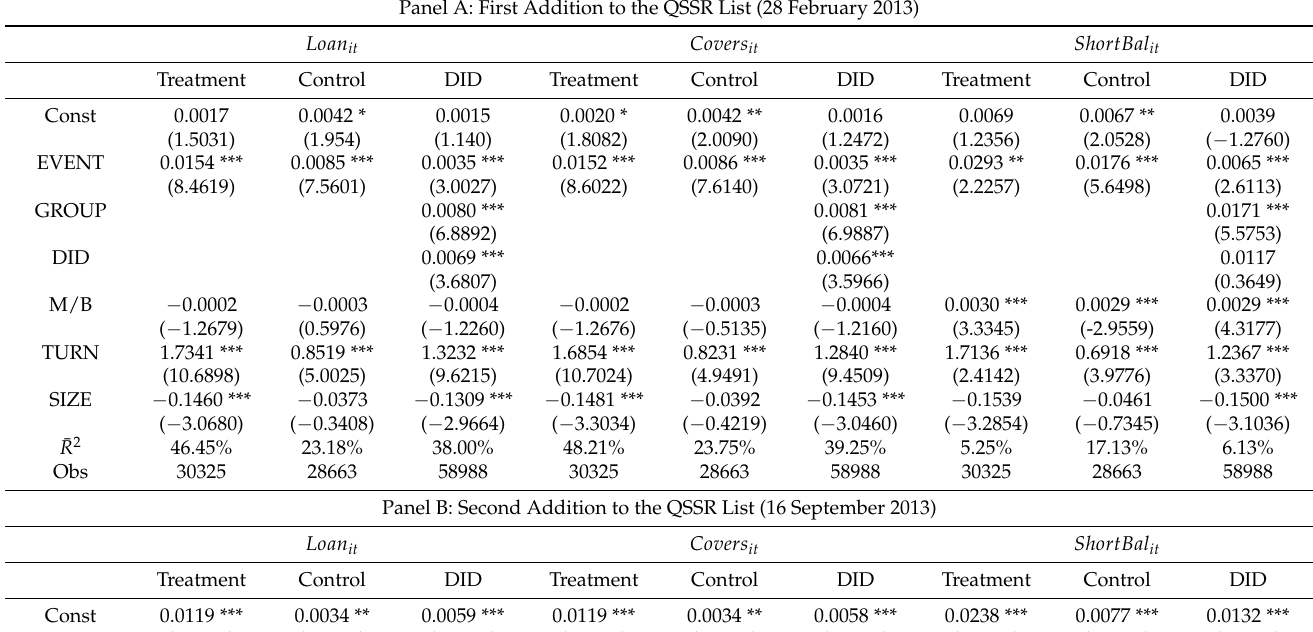
Table 5. Difference-in-differences regression of short-sale volumes after additions to the QSSR